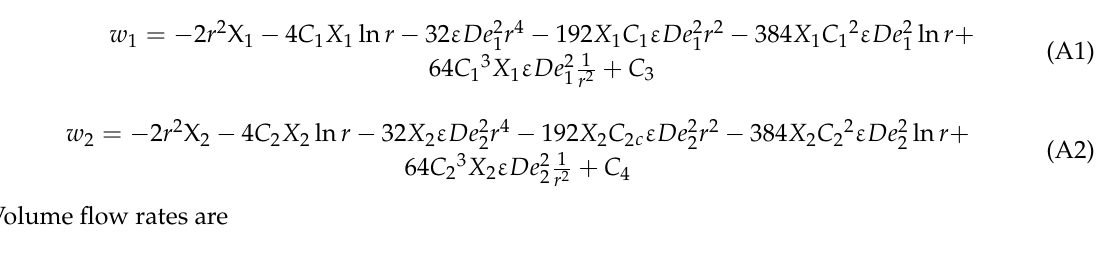
Figure 11. Effect of δ on thickness of coated fiber optics when 𝑋 (cid:2869) = 0.5, 𝑋 (cid:2869) = 1.0 , ε𝐷 (cid:2870)(cid:2870) = 10 .